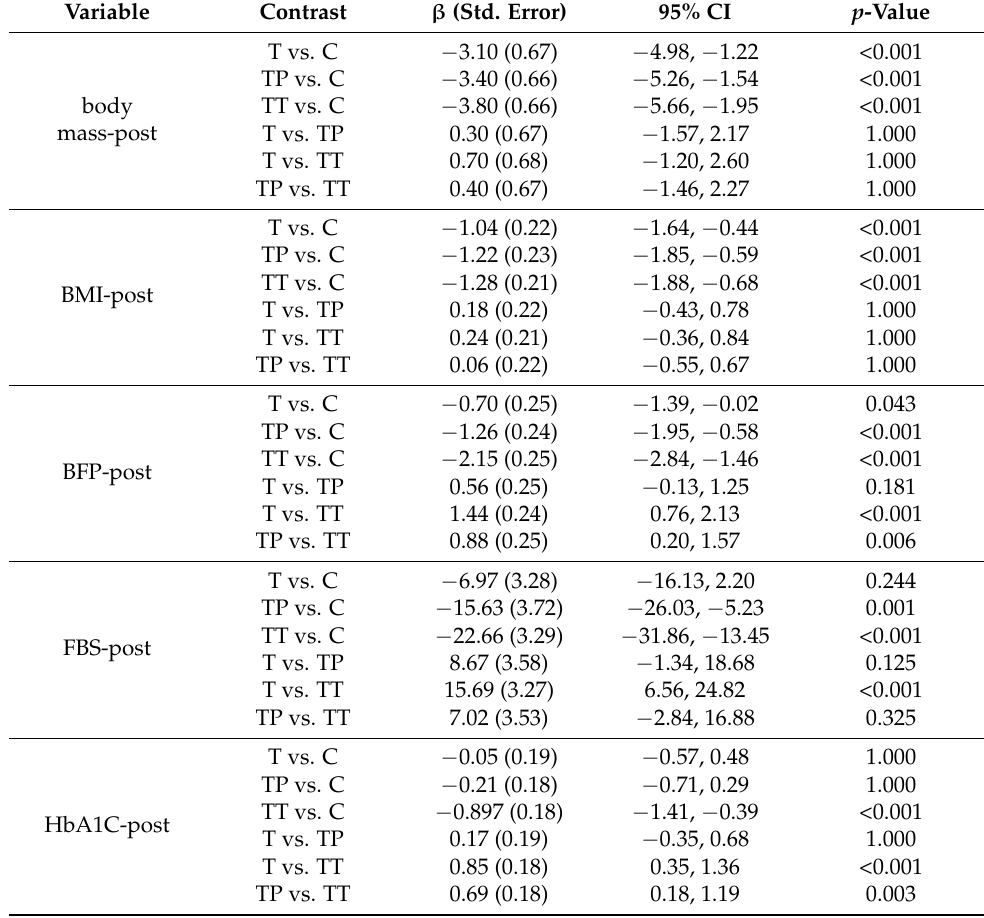
Table 3. The effect of group on the post-time markers controlled by the pre-time markers using